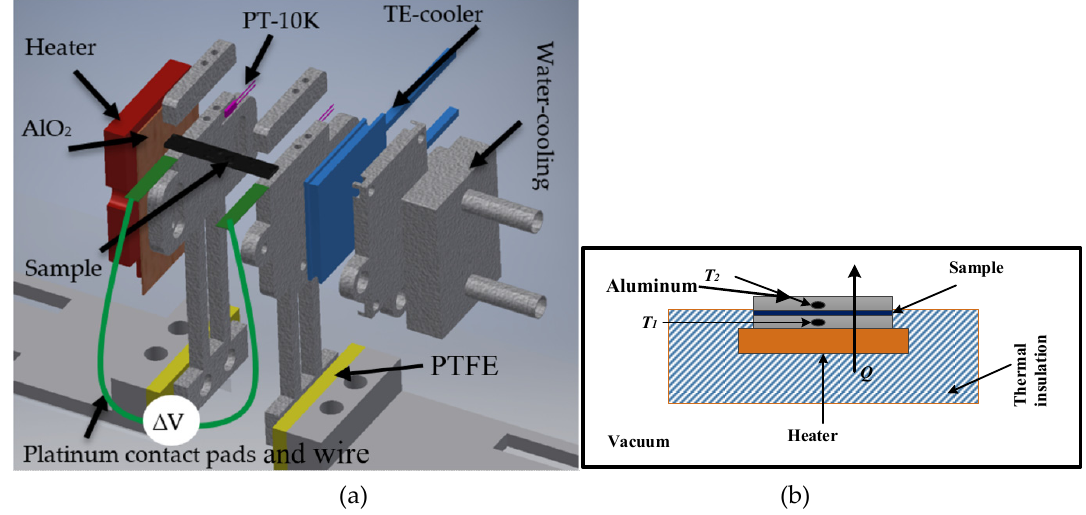
Figure 2. ( a ) A schematic view of the Seebeck measurement setup. The setup consists of two sides, heating side along with heater attached (red coloured), and cold side along with TE-cooler (blue coloured). All grey coloured parts are aluminium, the yellow coloured parts are PTFE, and orange coloured part is aluminium oxide. In ( b ), a schematic view of the thermal conductivity measurement setup, where heater and heating side is enclosed in multi-layered insulation, sample is sandwiched between the two aluminium pieces, and temperature sensors are installed inside the aluminium, and the whole setup was placed in the vacuum.